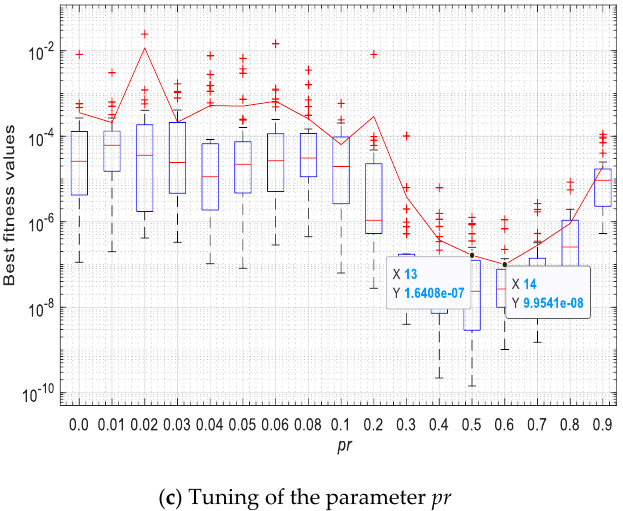
Figure 1. The parameter tunning for the proposed algorithm. Table 1. Descriptions of the nonlinear equation systems used in our experiments.